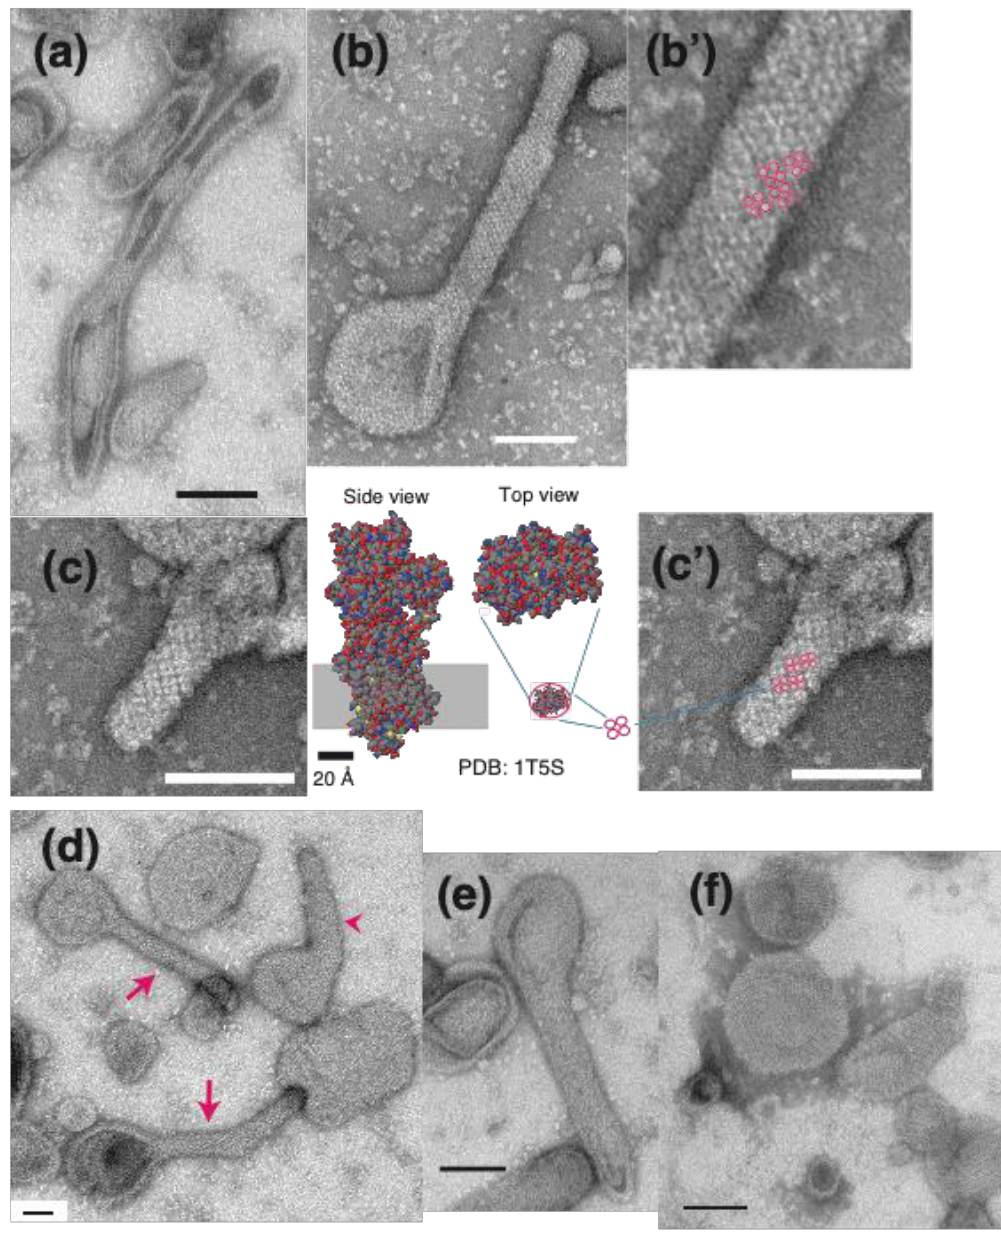
Figure 3. Typical images of the tightly elongated SR vesicles at 0.9 nM Ca 2+ or less at 0 ◦ C. The SR vesicles were classified as with or without a crystal-array of surface particles. With a crystal array ( a ) at 0.04 nM and ( b , c and d (arrows)) at 0.9 nM Ca 2+ . Without a crystal array ( d (arrowhead) and e ) at 0.9 nM Ca 2+ . When a crystal-array was difficult to distinguish the vesicle was classified as ‘without a crystal-array’. In ( b’ ) (enlargement of a region in b ) and ( c ), clear tetramer units of the surface particles are marked with circles. A model of a rabbit Ca 2+ ATPase monomer in the E 1 state with bound calcium (PDB 1T5S) [40] is shown for comparison. ( f ) Decavanadate-induced crystalline array of surface particles in the SR vesicles, as a reference; the SR preparation (1.0 mg of protein/mL) was incubated with 100 mM imidazol-HCl (pH 7.4) containing 0.12 M KCl, 5 mM MgCl 2 and 0.5 mM Na-decavanadate under the conditions of 0.02 nM Ca 2+ at 0 ◦ C overnight. Scale bars in ( a – c , c’ , e and f ): 100 nm. Scale bar in ( d ): 50